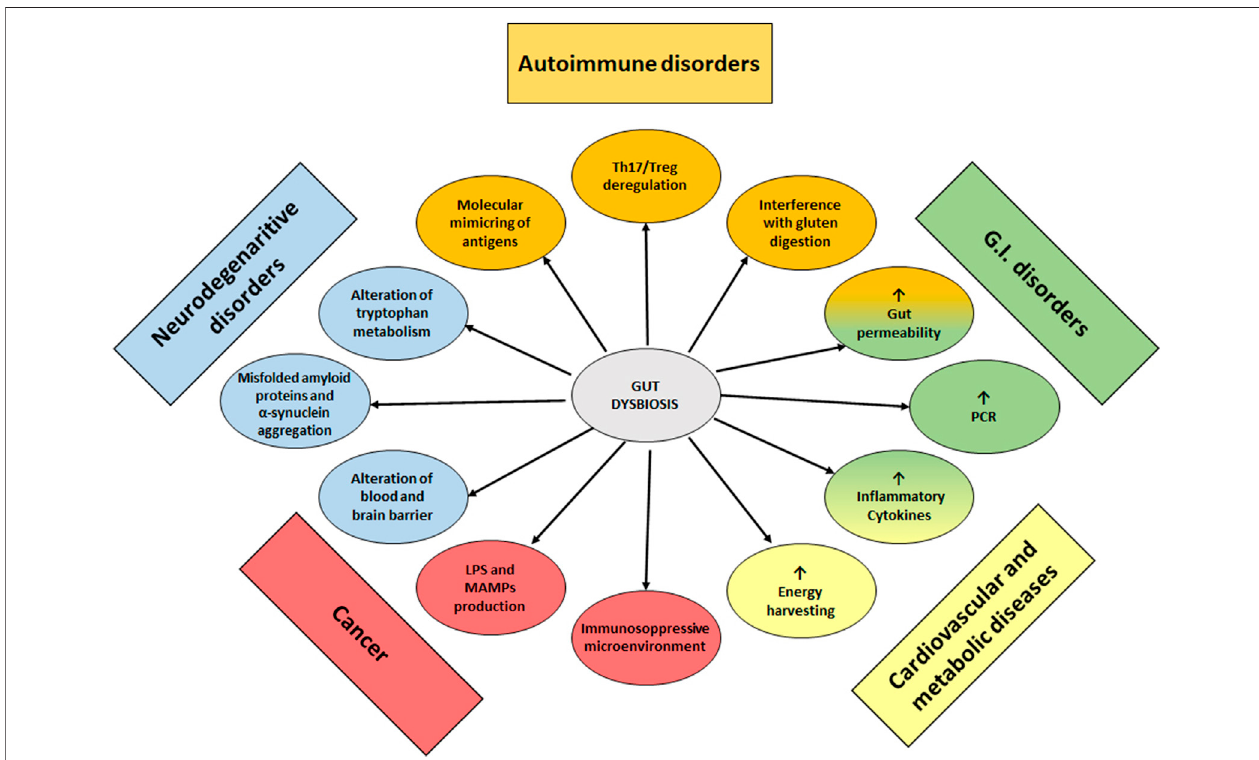
FIGURE 1 | Dysbiosis of GM as a cause or contributing cause of non-communicable diseases.